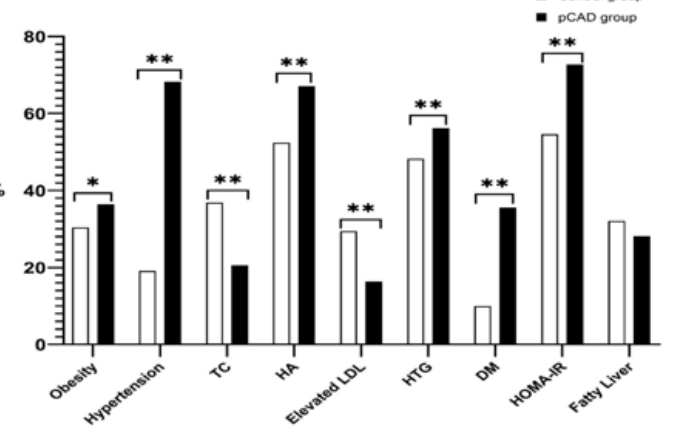
Figure 2. Prevalence of cardiovascular risk factors in the population studied. Data are presented in percentages. Significant p value * <0.05; ** <0.001. TC = total cholesterol; HA = Hypoalphalipopro- teinemia; Elevated LDL ≥ 130 mg/dL; DM = diabetes; HOMA-IR = Homeostatic Model Assessment for Insulin Resistance.